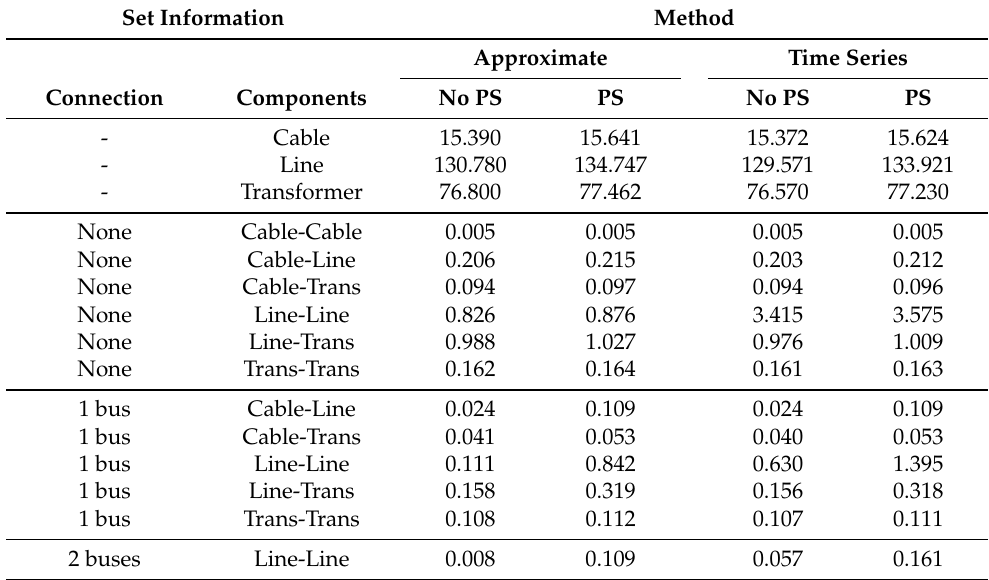
Table 2. Annual unavailability for outages within different set categories [ h / y ].